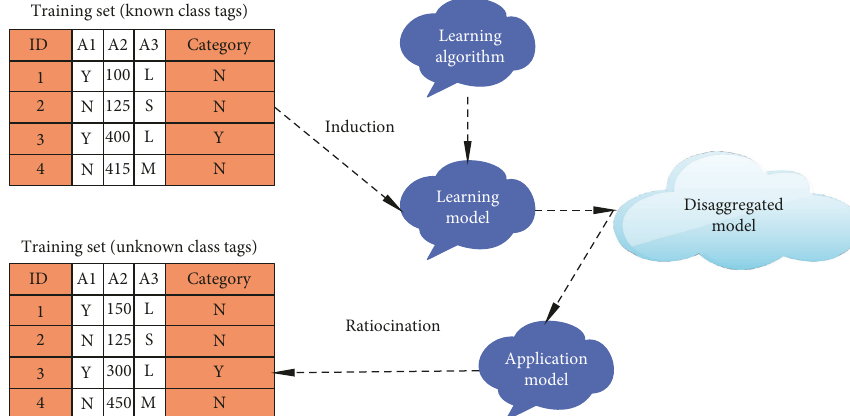
Figure 3: The basic idea of classification.